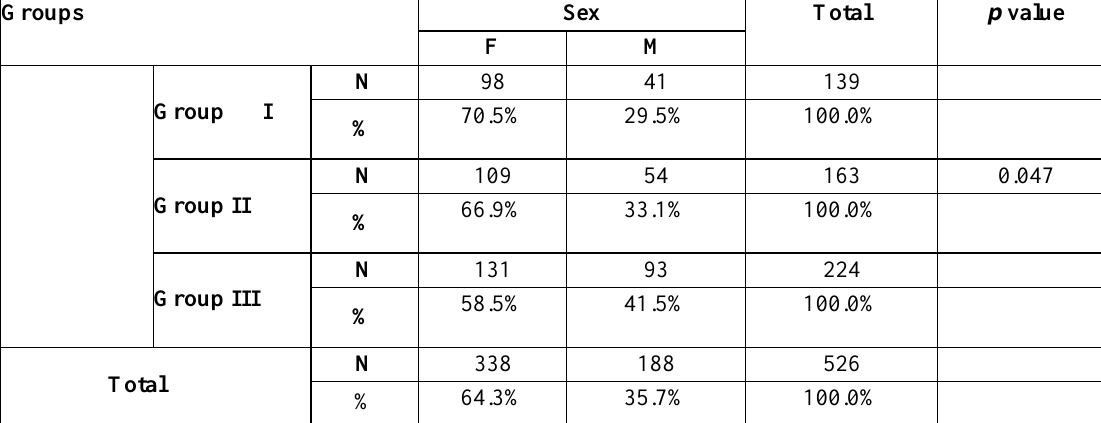
Table 2. Sex distribution among studied groups